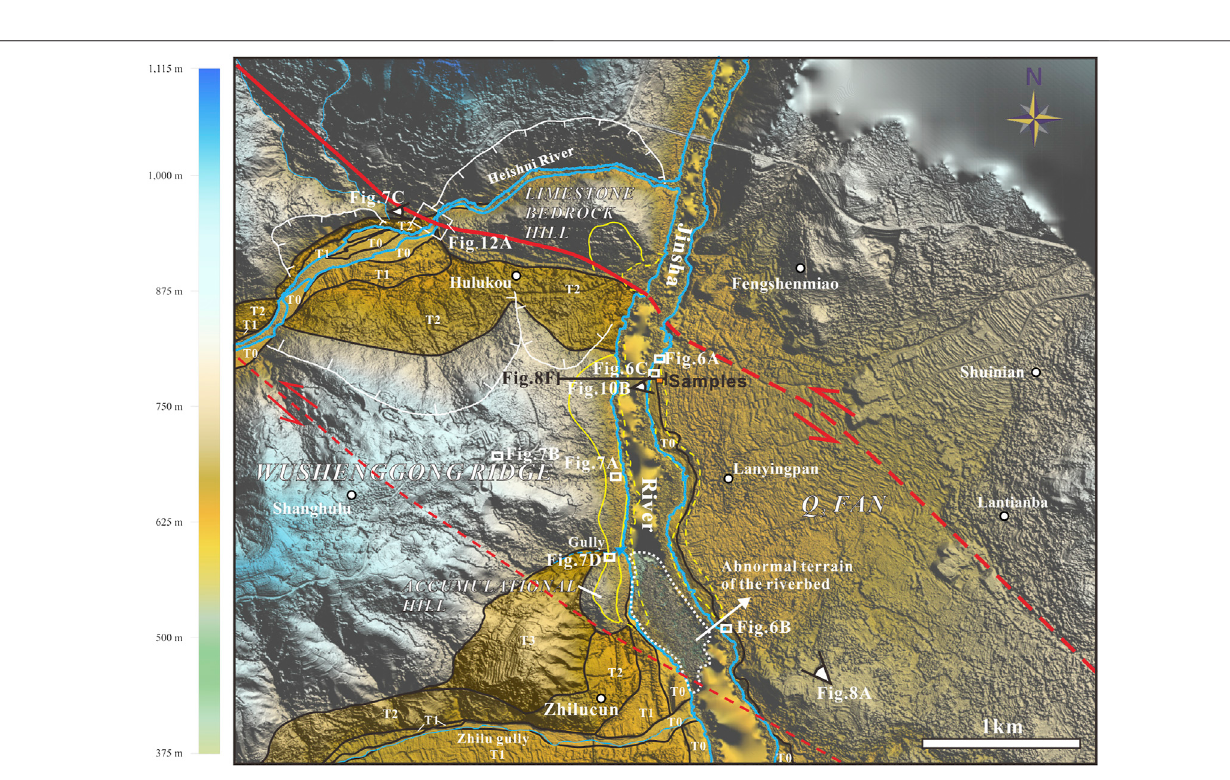
FIGURE 4 | DSM (res-0.6 m) of the topography around the landslide; red solid line and thick red dashed line indicate the current Qiaojia Segment trace, thin red dashed line indicates the previous Qiaojia Segment trace; jagged white lines show the crown of the early landslides; yellow solid lines circle the source of the failed slope collapse to be discussed in this paper, yellow dashed lines to the west of the Jinsha River indicate the near-source deposit, and the yellow dashed line to the east of the Jinsha River circles the spatial distribution of boulders from this failed slope collapse. All terraces are outlined with black lines. Solid orange rectangle shows the sample locations, as well as the locations in Figure 9